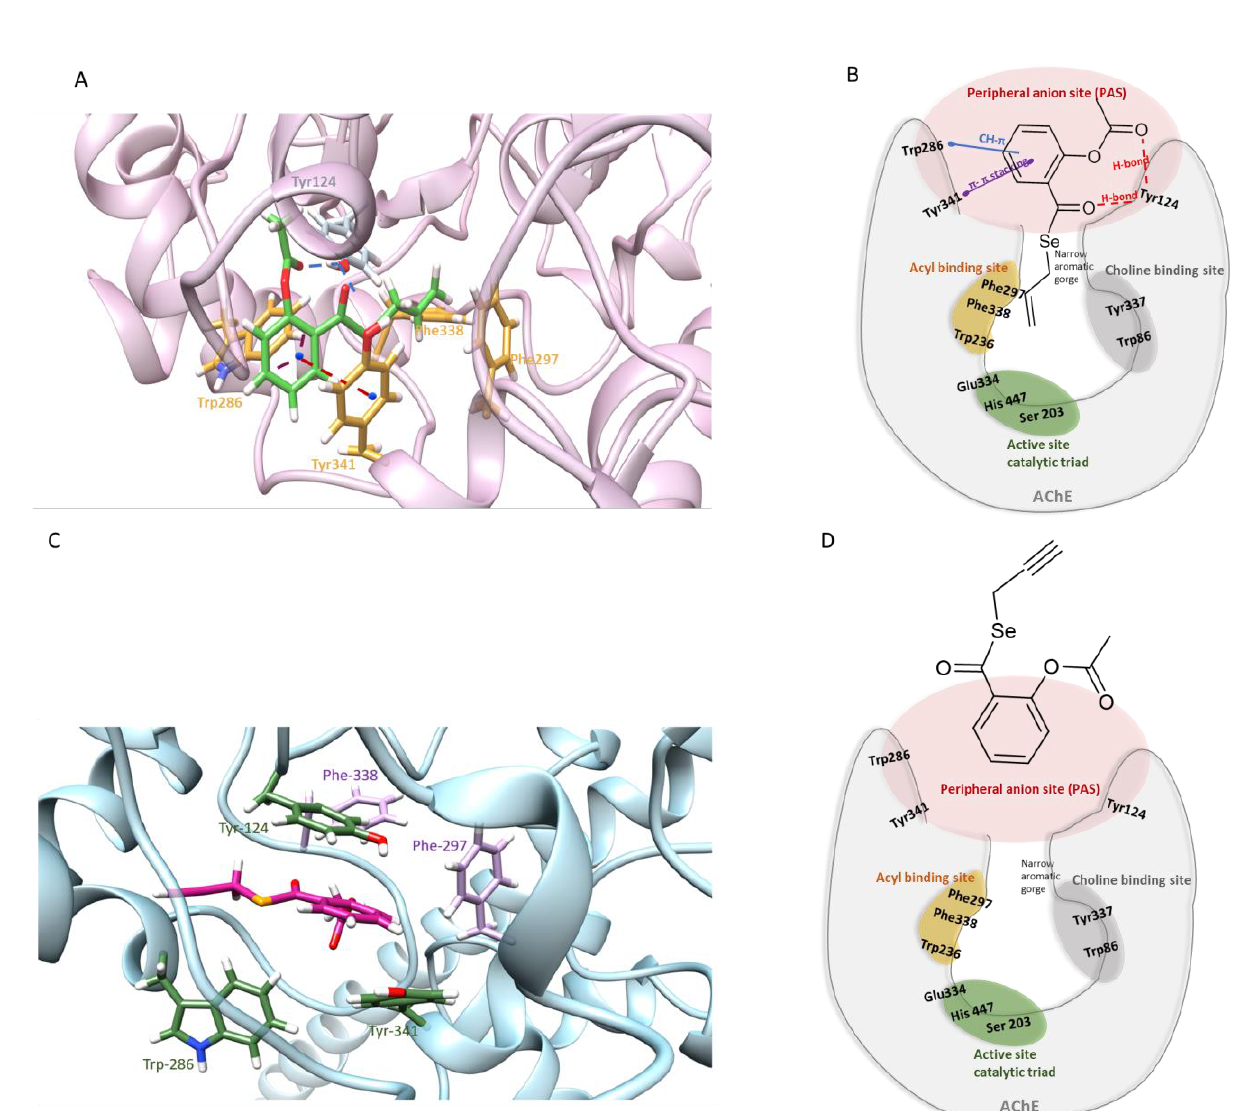
Figure 7. Interactive models of compounds 14a ( A , B ) and 14b ( C , D ) with the residues in the binding pocket of AChE (code PDB 4BD7).